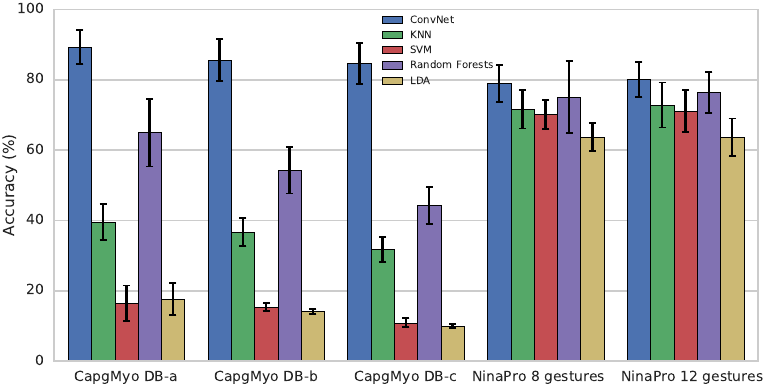
Figure 5. Recognition accuracy of hand gestures with instantaneous values of sEMG signals for different datasets and recognition approaches. Each group of columns represents a specific experiment. Different colours represent different recognition approaches: ConvNet (deep convolutional network) with instantaneous sEMG images, KNN (k-nearest neighbours), SVM (support vector machine), Random Forests and LDA (linear discriminant analysis). Bars denote average recognition accuracies over different subjects. Error bars denote standard deviations.